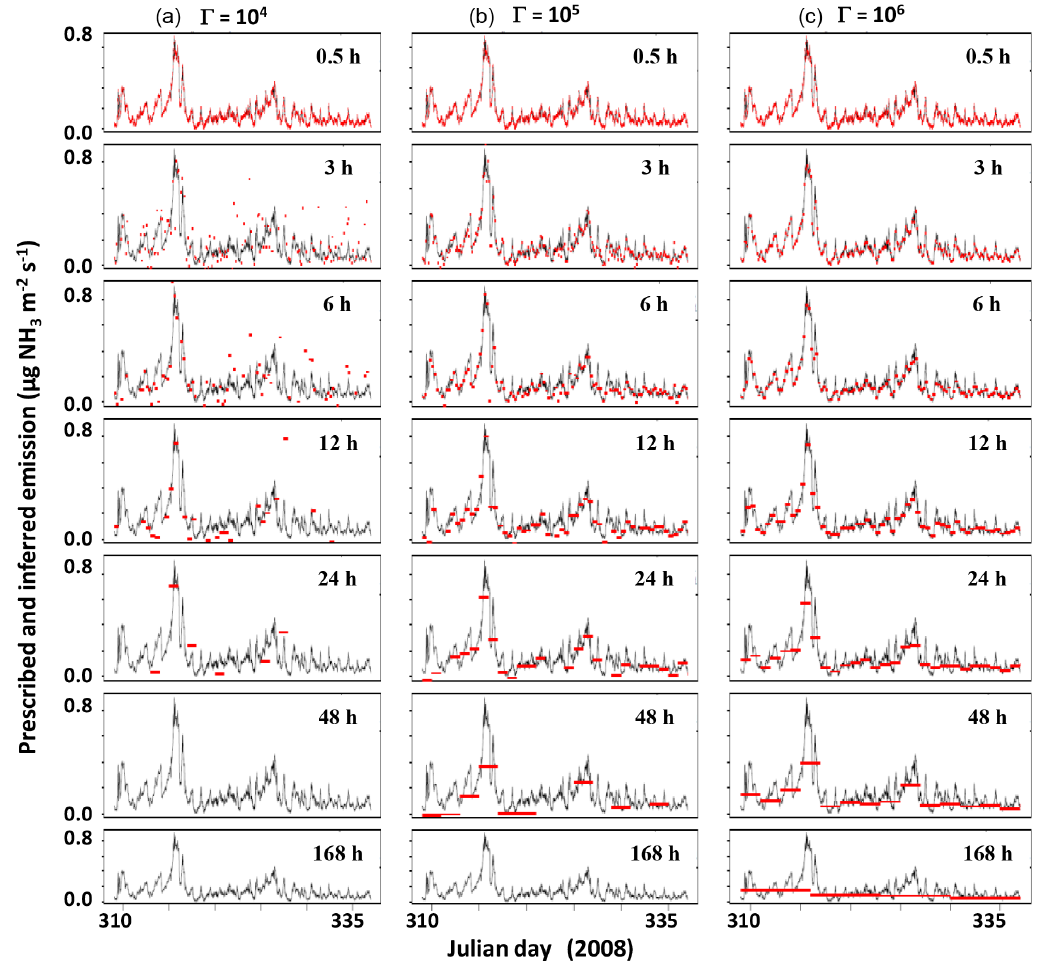
Figure 8. Example result of multiple plot case inference. Black curves: observations; red dots: inferred sources. (a) Treatment 1, (cid:48) = 10 4 . (b) Treatment 2, (cid:48) = 10 5 . (c) Treatment 3, (cid:48) = 10 6 . Missing red dots are out of the y -scale boundaries. Example plots from treatments 1, 2 and 3 are shown from left to right. The period is the same as in Fig. 7 (November 2008 for the FR-Gri ICOS site), and emissions are up to 1, 10 and 100µgNH 3 m − 2 s − 1 for the three emissions potentials. Strategy C7 with target heights 0.25 and 1m, and source width 25m on a